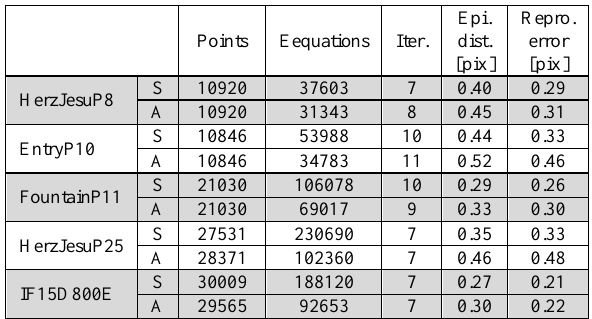
Table 3. Comparison of the two suggested cost functions (S: symmetric, A: accumulated). From left to right: number of points, resulting number of equations (both during first iteration), Gauß-Newton iterations, final RMS of epipolar distances and corresponding reprojection error for the feature points.